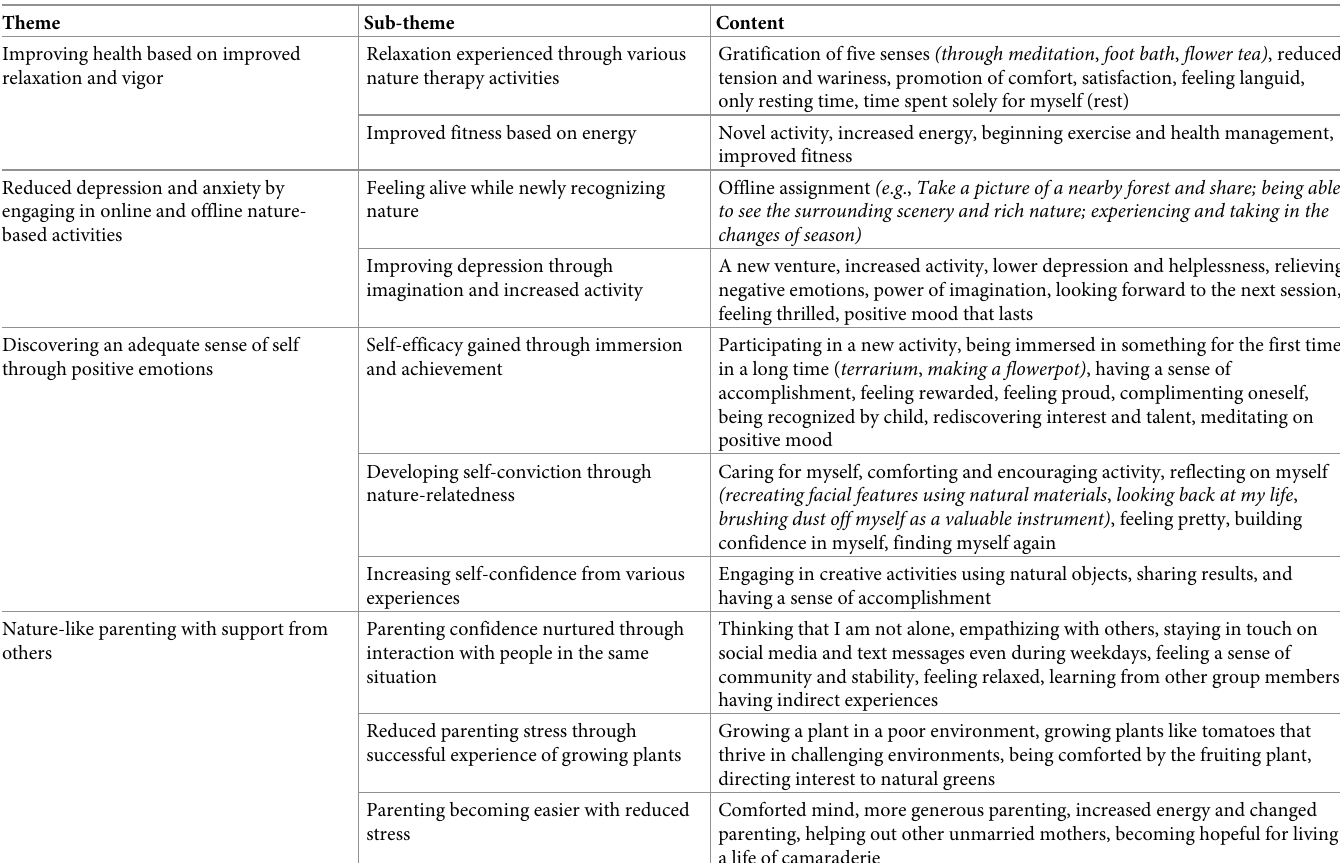
Table 5. Themes from the natural wellness real-time video group